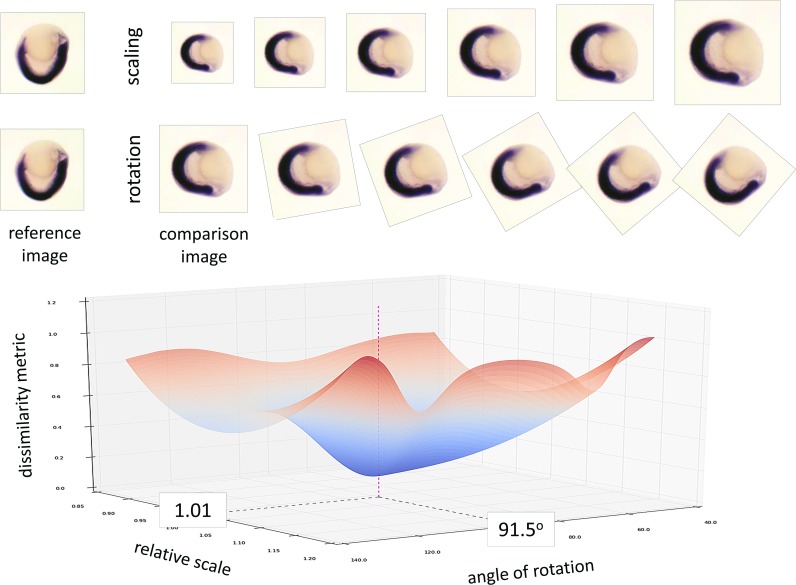
Simplified example of spherical stage image similarity clustering.Early development stages are routinely photographed from different directions to maximise information about the expression pattern. Reference and comparison images for the same gene and stage are compared under multiple transformations (scale, rotation, shear) to identify the set of transformations that minimises their dissimilarity. Here we see that a 91.5o rotation and a 1.01 scaling suggest the most likely transformation between these two images. All images from the same gene and stage are compared with each other to identify images from (probably) the same view-point. See also Fig 3B.